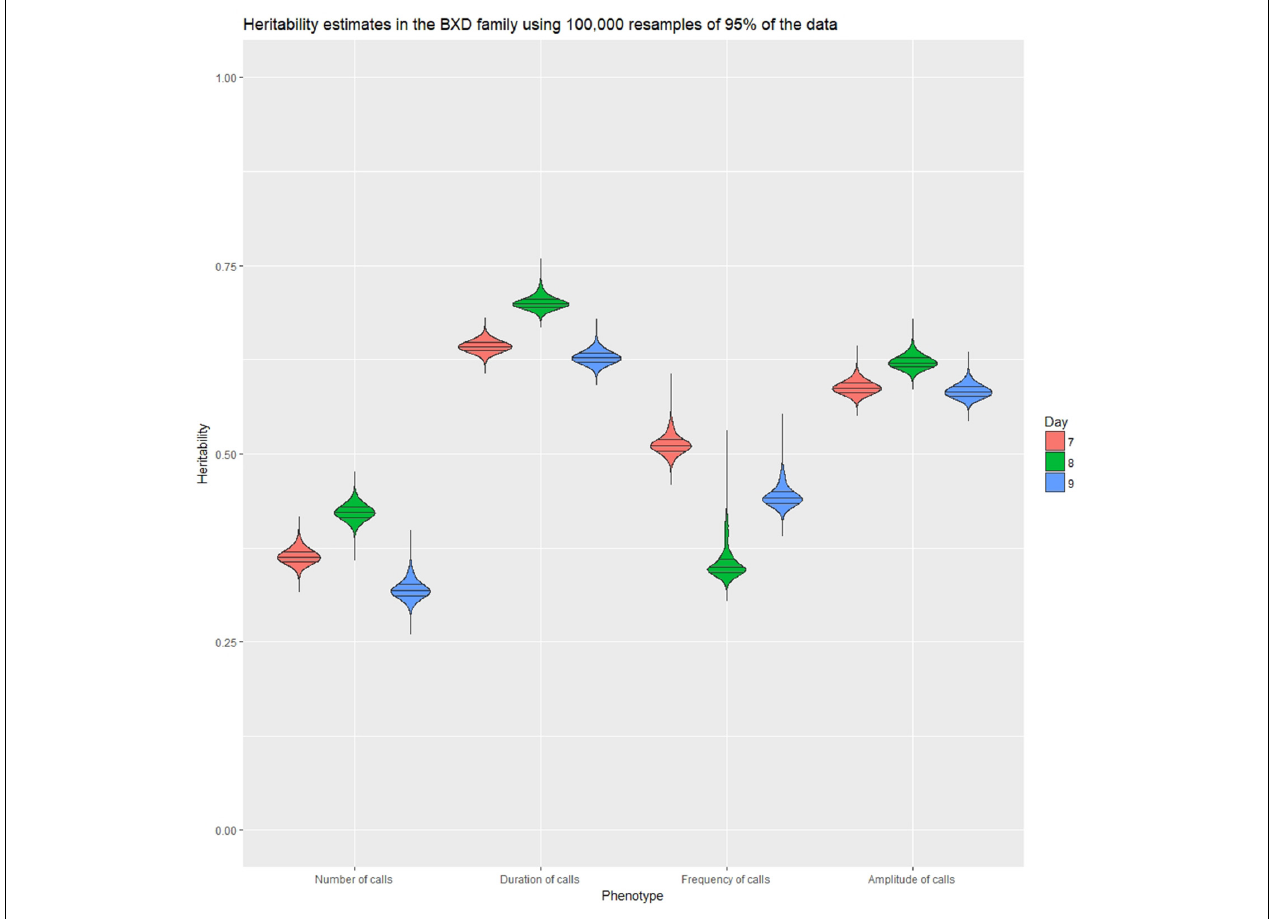
FIGURE 9 | Violin plot of heritability estimates in 100,000 random subsamples 95% of the data for the four quantitative traits on postnatal days 7, 8, and 9. Quartile intervals are shown by black lines, and days are represented by red, green, and blue fill, respectively.